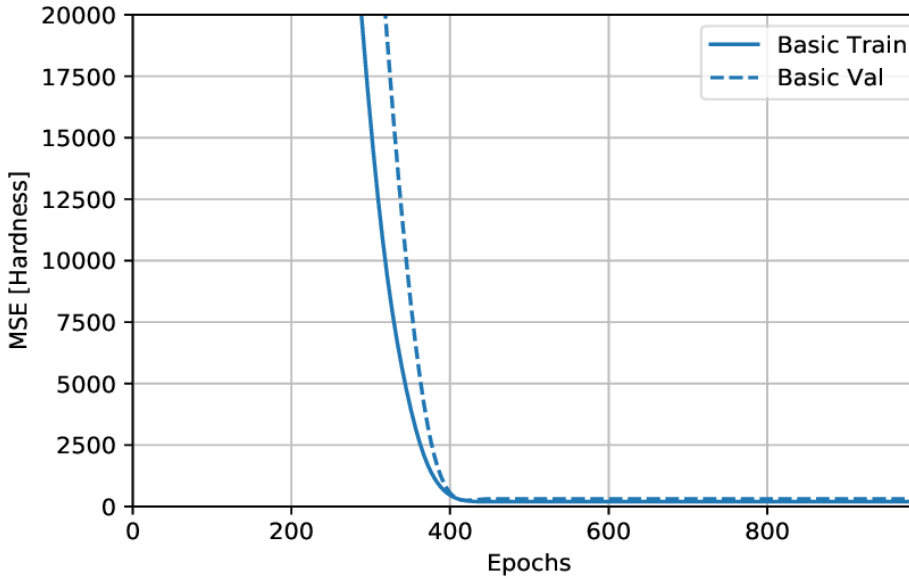
Figure 9. Plots of MSE against number of epochs.